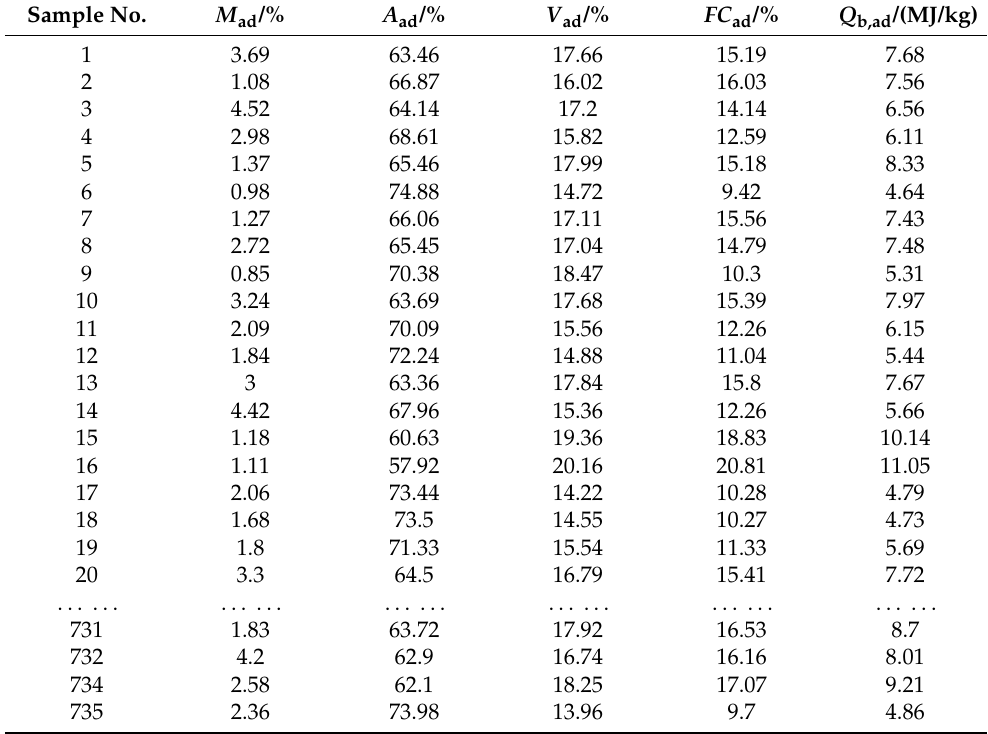
Table 1. Partially measured samples of coal gangue. Sample No.